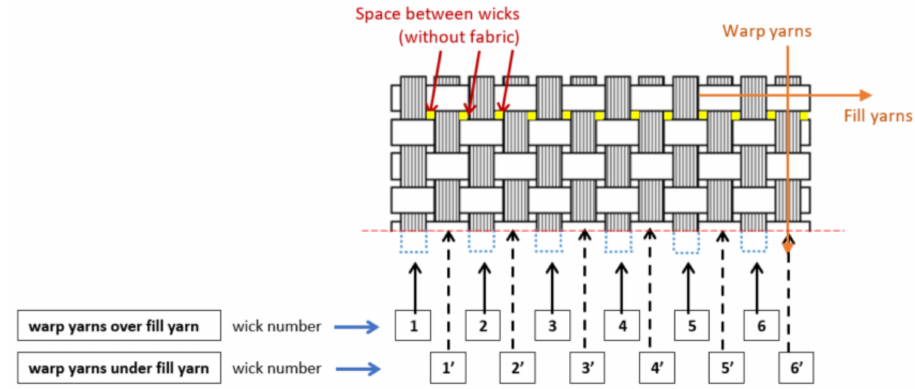
Figure 5. Warp yarns identification.